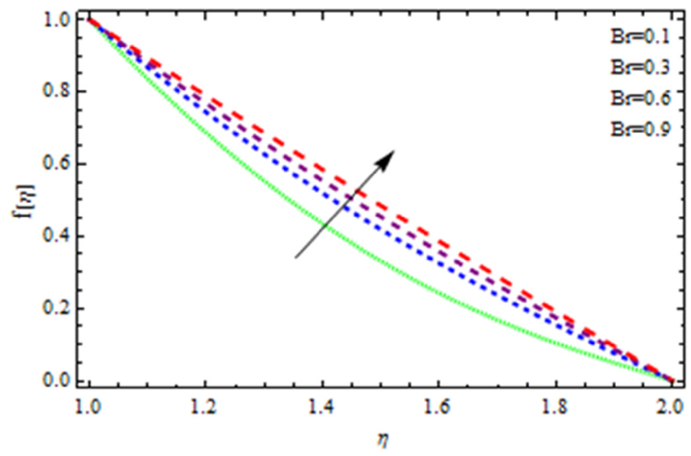
Figure 6. Influence of Br on the velocity curve.